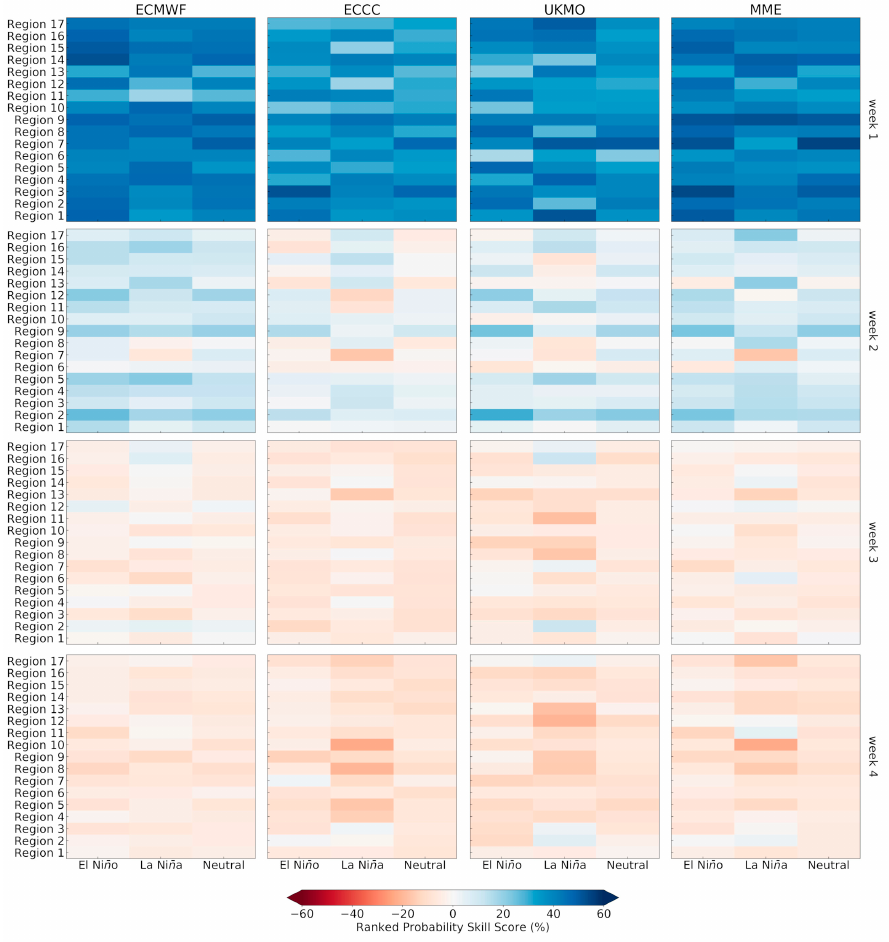
Figure 14. Ranked probability skill score of week 1, week 2, week 3, and week 4 precipitation forecasts in each of the ENSO phases during the boreal summer monsoon.